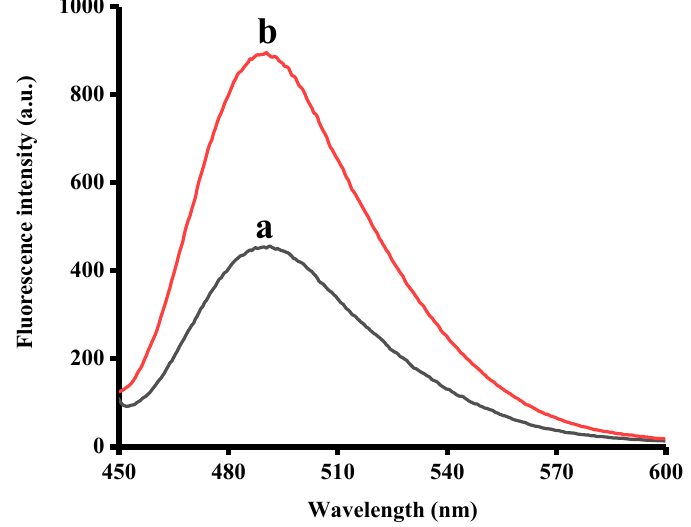
Figure 2. Fluorescence emission spectra in the absence (a) and presence (b) of ADA. The selected ADA concentration was 2000 concentration was 2000 U/L.